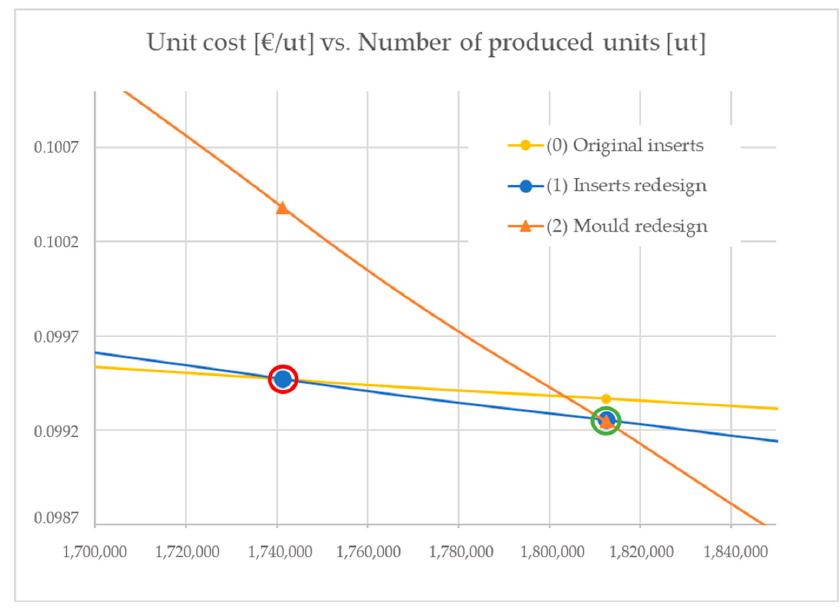
Figure 10. Equilibrium points when analyzing the costs per unit produced as a function of the number of produced units for the three injection moulding strategy scenarios: (0) original inserts, (1) insert redesigns and (2) mould redesigns. Equilibrium between (0) and (1) occurs at 1,741,302.5 produced parts (red circle) and equilibrium between (1) and (2) at a figure of 1,812,508.2 produced parts (green circle).